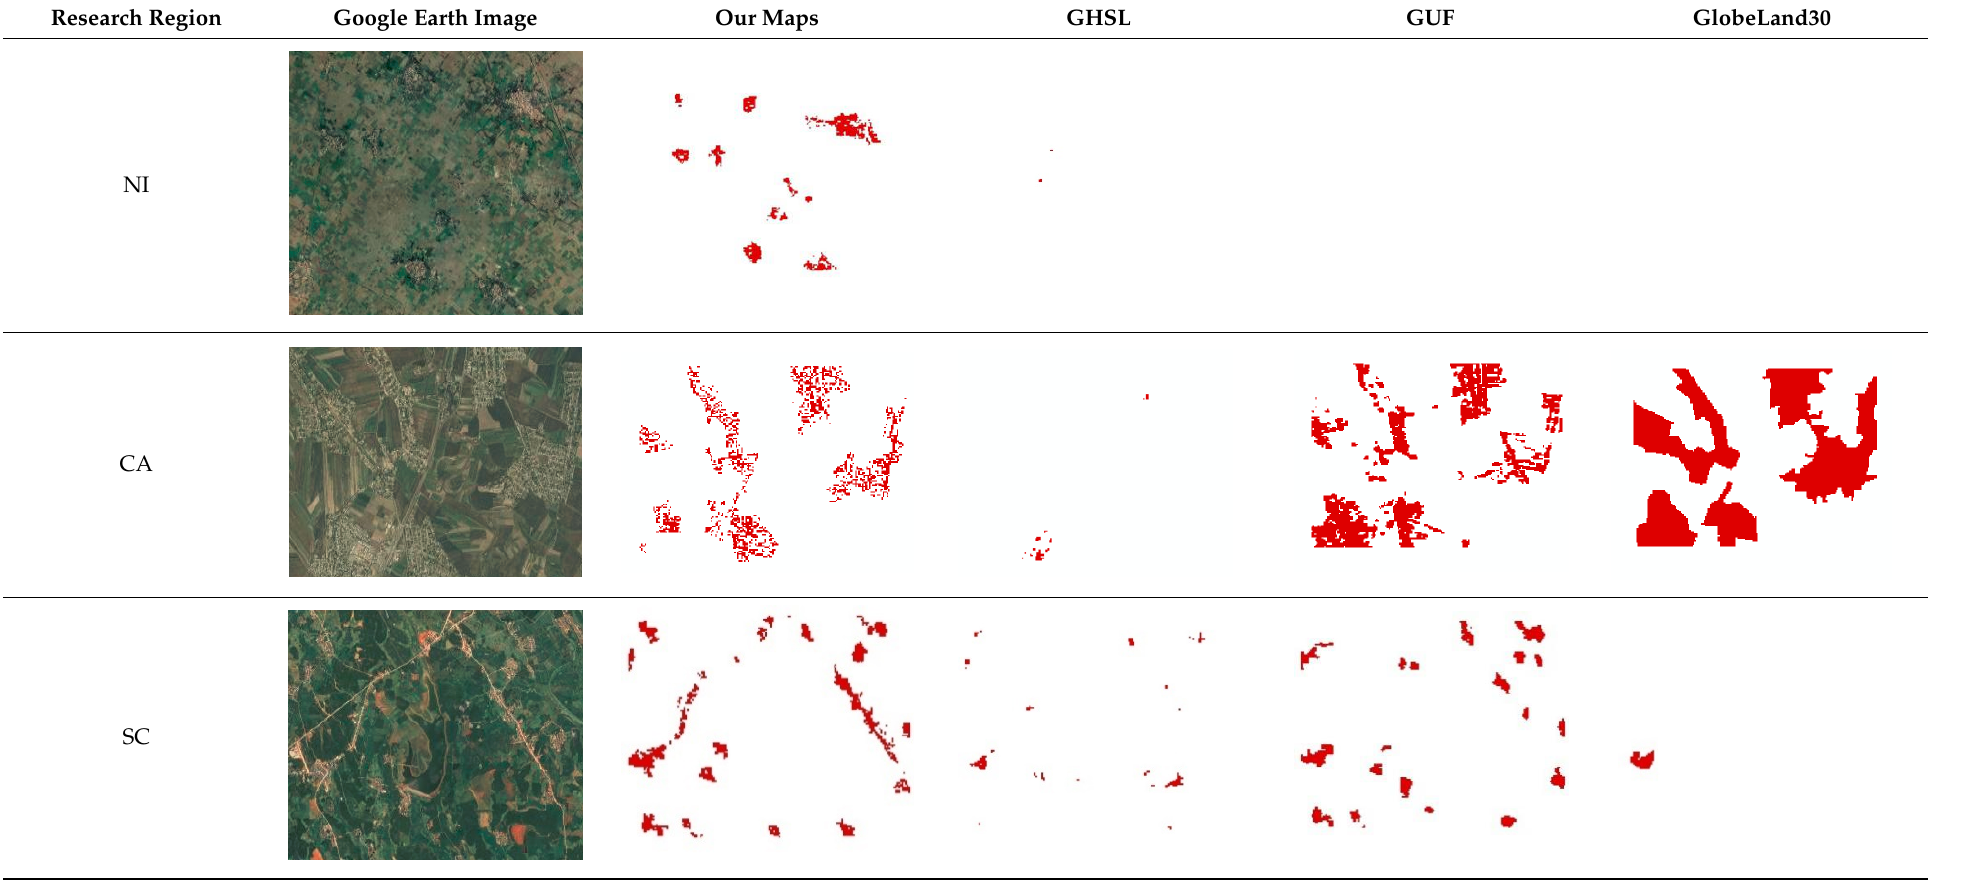
Table 2. Comparison of the extent of rural settlements mapped in this study and existing products.